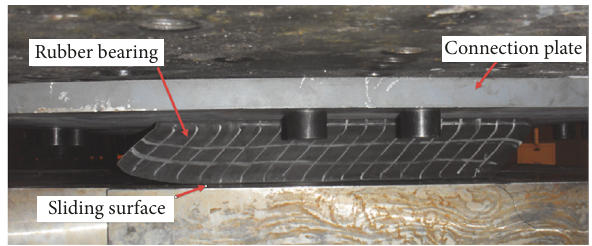
Figure 1: Diagram of the friction sliding test.